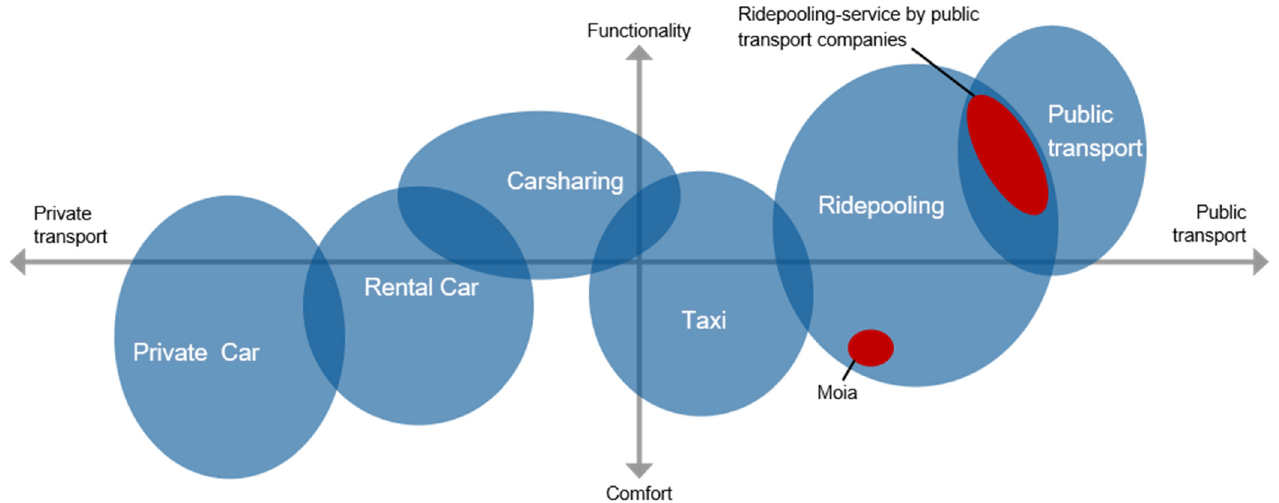
Figure 2. Position of ride-pooling compared to other mobility offerings (i.e., how it measures to the others). The situation presented and the classification made relate to the German market. Offers can differ greatly regionally due to their positioning. (Own diagram based on Gaul [18].)